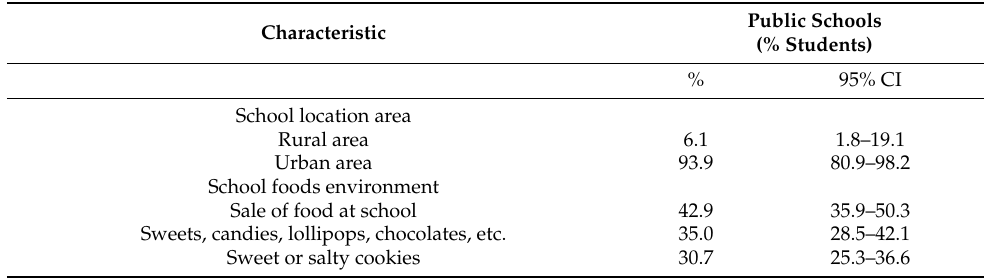
Table 3. Characteristics of school environment. Study of Cardiovascular Risks in Adolescents (ERICA), Brazil,